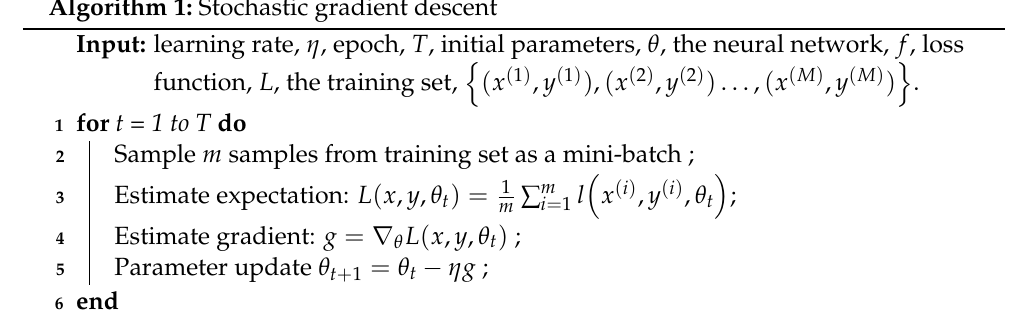
Algorithm 1: Stochastic gradient descent